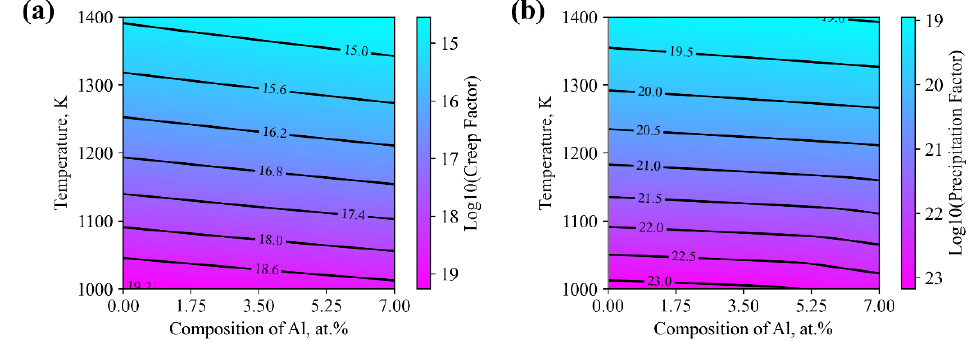
Figure 8. Evaluated ( a ) creep factor and ( b ) precipitation factor of the Alx(CoCrFeNi)1-x alloys based on the assessed kinetic description.